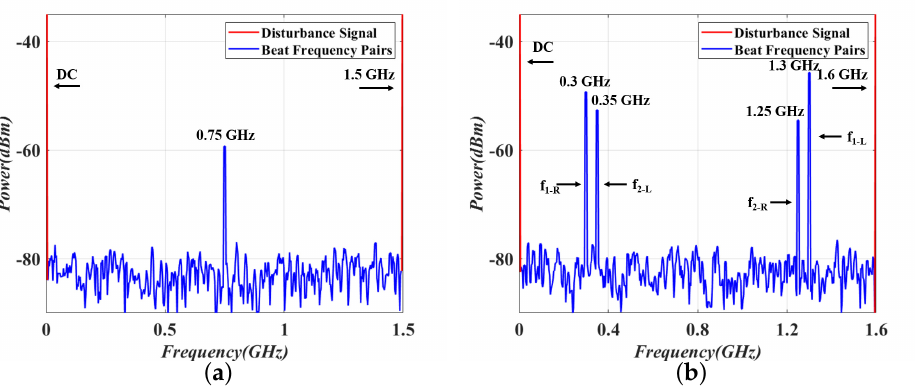
Figure 11. Receiving results for incoming signals at 4.5 and 6.75 GHz, where the comb spacing is ( a ) 1.5 GHz and ( b ) 1.6 GHz.